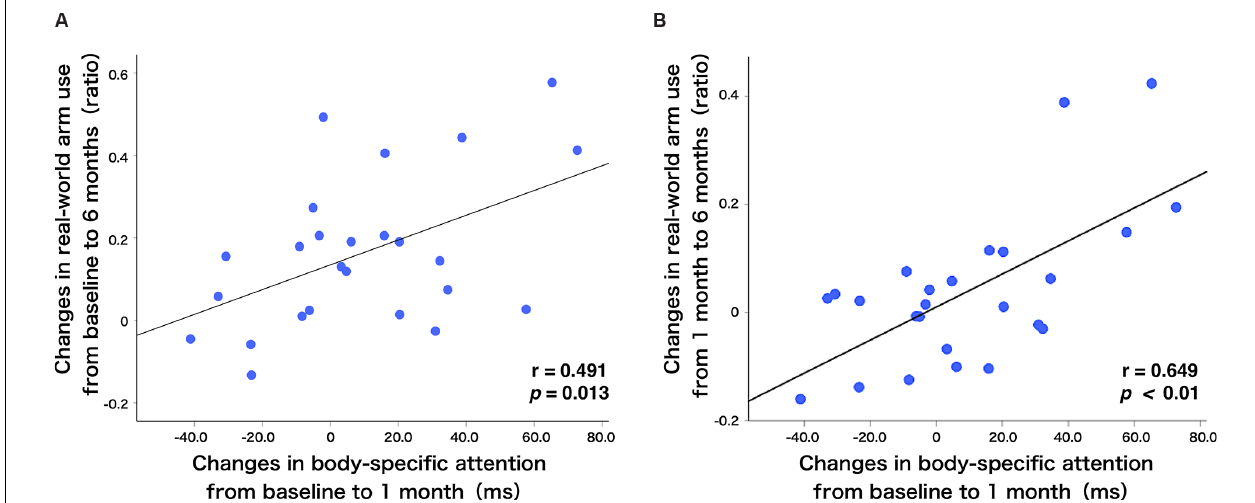
FIGURE 4 | Relationship between real-world arm use and body-specific attention. (A) There was a positive correlation between the changes in body-specific attention from baseline to 1 month and the changes in the real-world arm use from baseline to 6 months ( r = 0.491, p = 0.013). (B) Additionally, there was a positive correlation between the changes in body-specific attention from baseline to 1 month and the changes in the real-world arm use from 1 month to 6 months ( r = 0.649, p < 0.01). The blue dots represent individual patients.